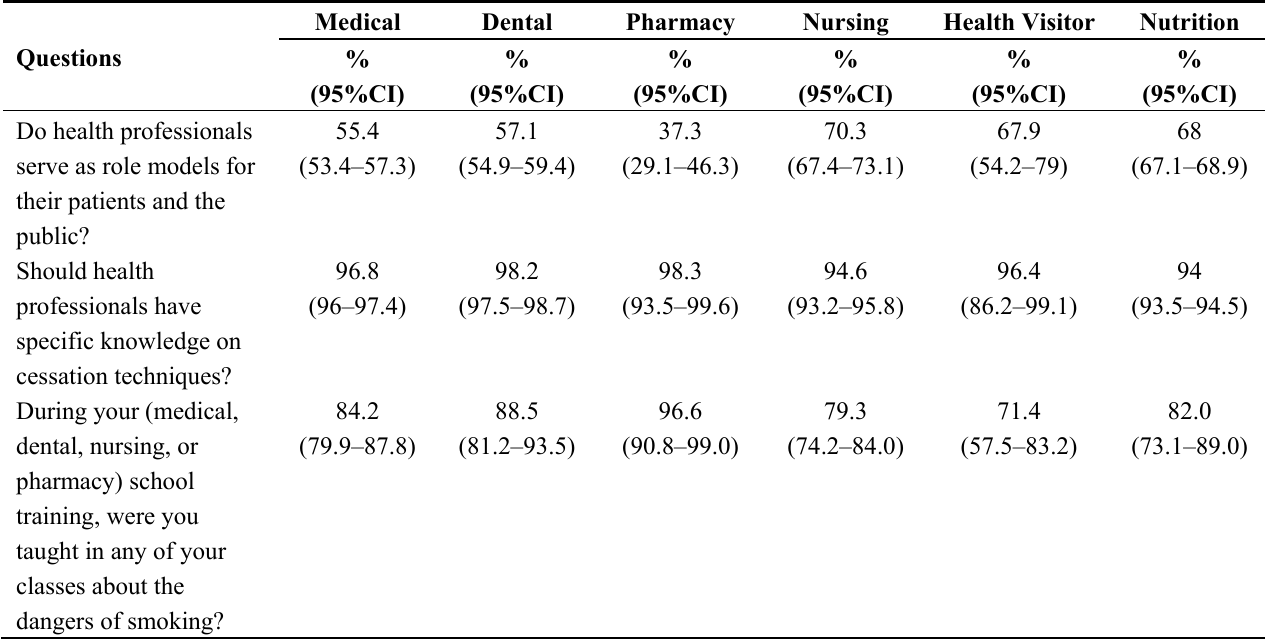
Table 5. Curriculum/Training among Third-Year Health Professional